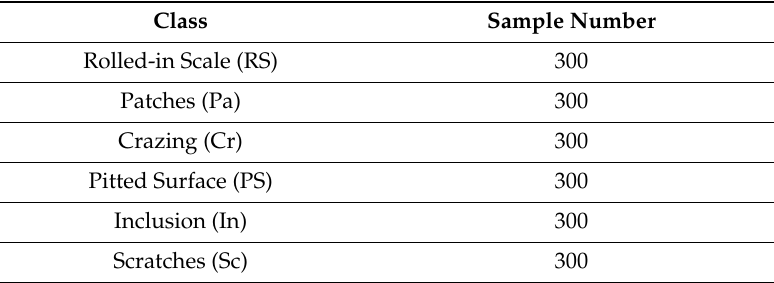
Table 4. Public NEU defect